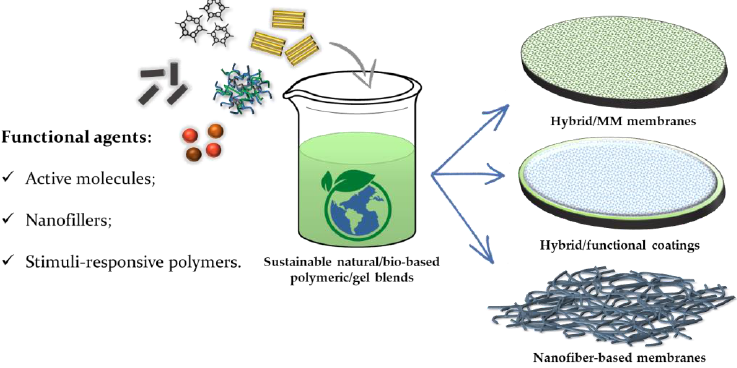
Figure 4. Innovative and ecofriendly approaches for water filtration membranes modification.